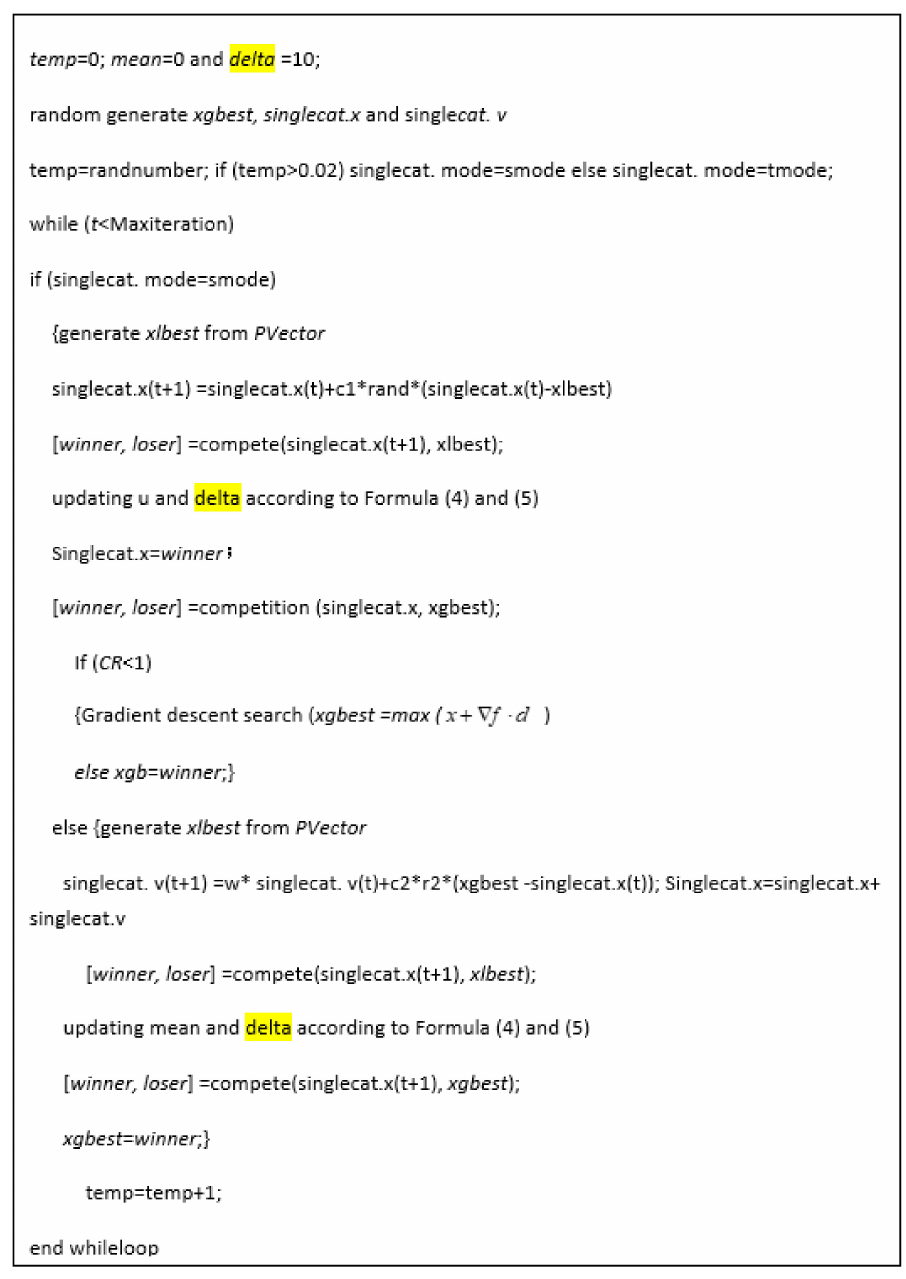
Figure 7. The pseudo-code for